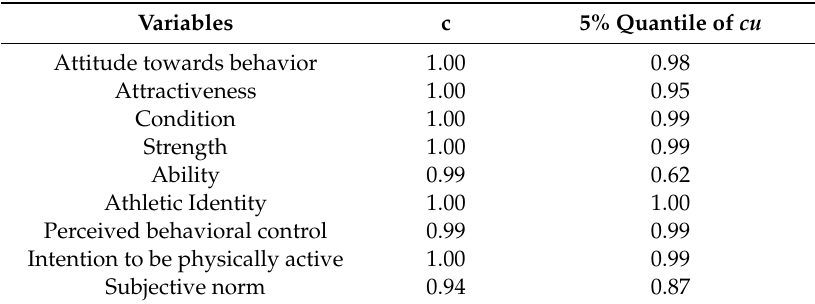
Table 4. Compositional invariance